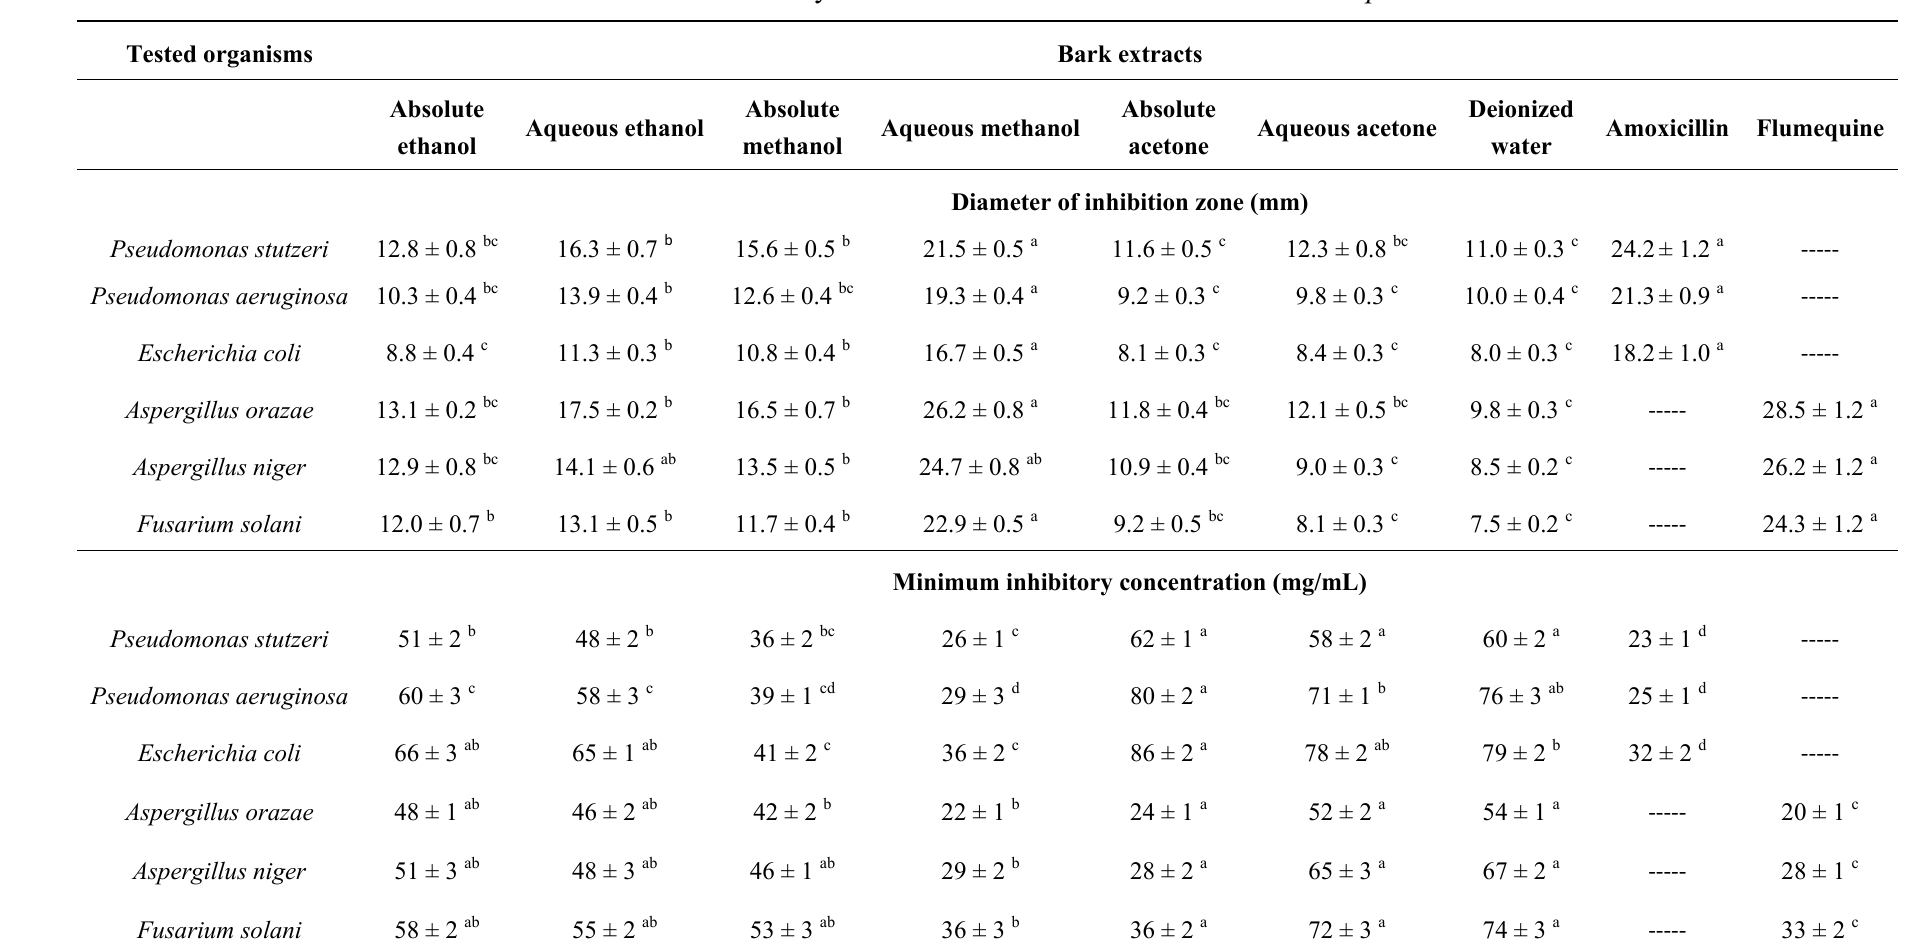
Table 3. Antimicrobial activity of different solvent extracts from bark of P. pinnata .